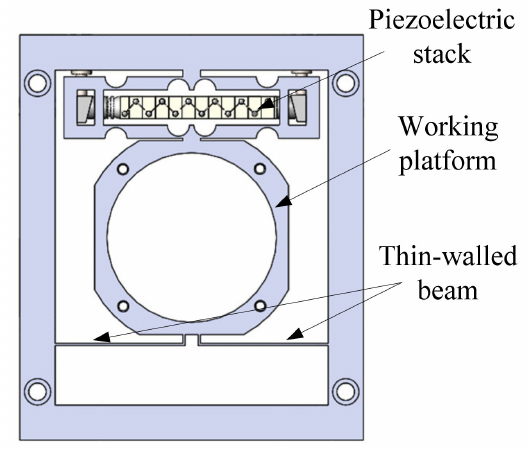
Figure 4. The structure of the stabilization mechanism.